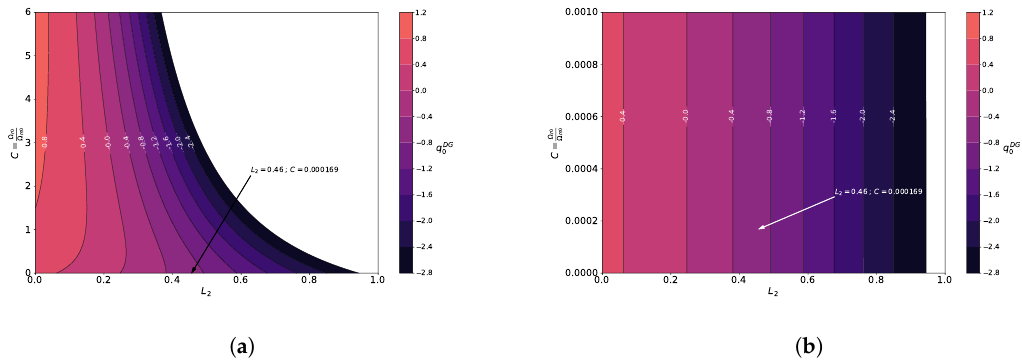
Figure 13. q DG for different combination of L 2 and C values. The fitted values found by MCMC analysis 0 is indicated in the Figure. ( a ) C values go from 0 to 6 to explore various Universes, even a Universe wholly dominated by radiation. ( b ) The C values are bounded to very little values, nearly close to the C fitted value obtained by